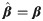
Compare the estimation accuracy of different deconvolution approaches (the values in parentheses are R2 and R).Based on {5%, 10%, 20%, 30%} percentage of outliers, we computed R2 to evaluate how well the estimators fit for a straight line β^=β. (A) random error with standard normal distribution, (B) random error with t-distribution.